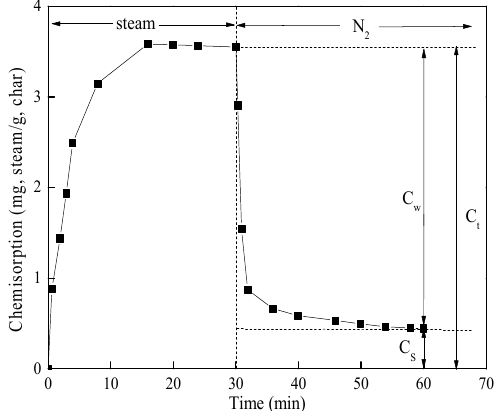
Figure 1. Steam chemisorption of petroleum coke (PC) char.